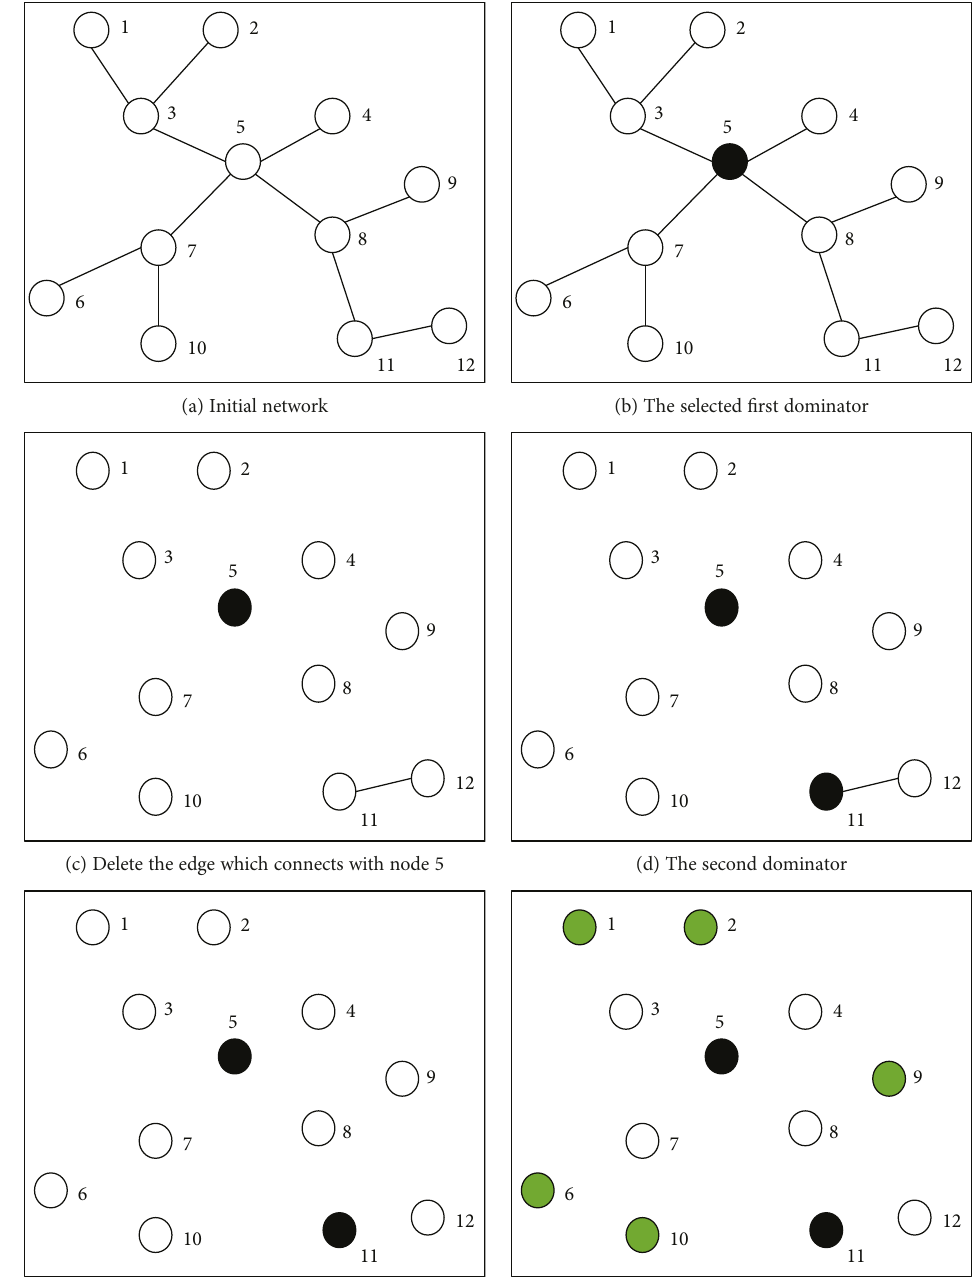
Figure 5: The process of constructing